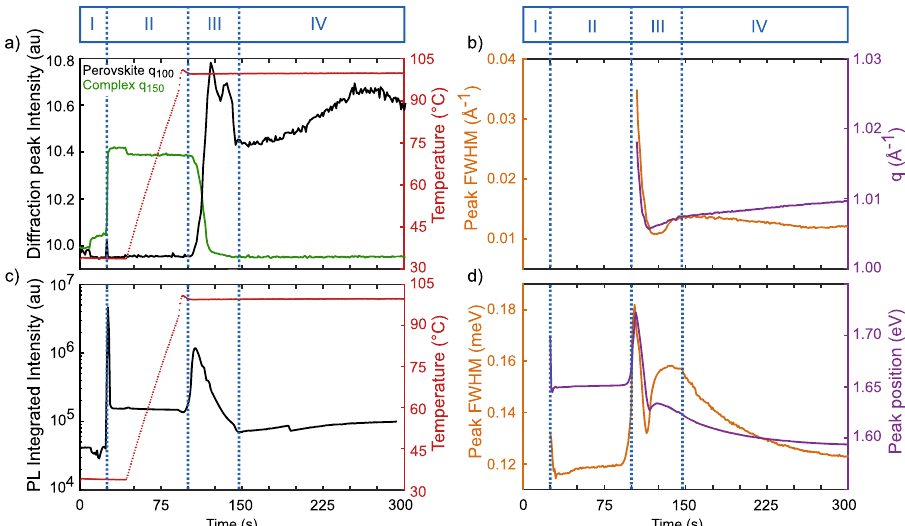
Fig. 3 Temporal evolution of characteristic parameters. a The temporal evolution of radially integrated GIWAXS data of MAPI (black) and MAPI·DMSO solvent-complex (green) as well as temperature (red) and ( b ) perovskite lattice parameters peak full width at half maximum (FWHM, orange) and q position (purple) during the crystallization process of perovskite solvent complex at 100 °C. c Integrated PL emission intensity (black) during nucleation, annealing, and dissolution-recrystallization processes of thin fi lm as well as temperature (red) and ( d ) Evolution of PL peak parameters peak FWHM (orange) and position (purple) during crystallization experiment. The four phases are indicated with vertical dotted